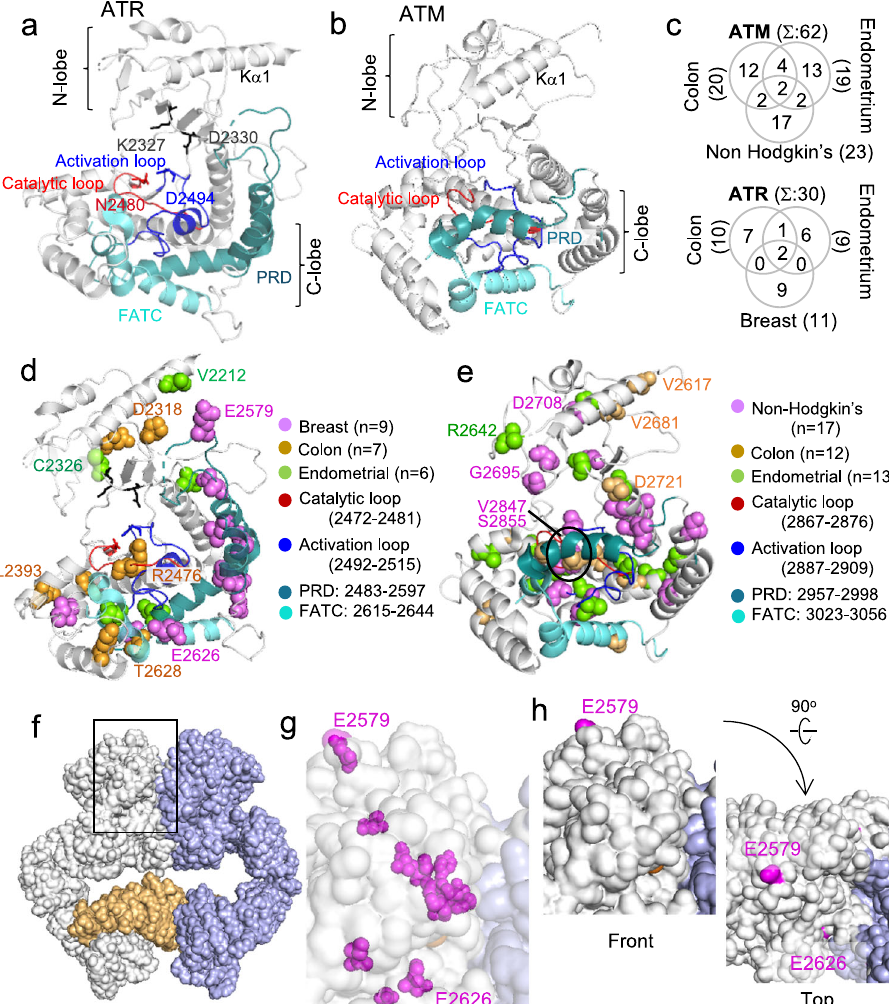
Fig. 4 Molecular modeling analysis of ATM/ATR kinase domain residues implicated in cancer. a Kinase domain of an active ATR enzyme complex (PDB 5YZO, 4.70Å) 10 . The PRD is positioned away from catalytic center to allow substrate access. The K2327 and D2330 support ATP association. The N2480 and D2494 stabilizes Mg 2 + for catalysis 10 . b Kinase domain of an inactive ATM enzyme complex (PDB 5NPO, 5.70 Å) 9 . The PRD sterically hinders substrate access to the catalytic center. c Extent of overlap among the ATM/ATR residues mutated in the indicated cancer type that are the kinase domain (Fig. 2b, Supplementary Fig. 2a, and Supplementary Data 3 and 4). d , e The kinase domains of ATR ( d ) and ATM ( e ), showing location of the conserved residues mutated in the indicated cancer type. Labeled residues are solvent accessible ( h , g ) Supplementary Fig. 4f, g). f A surface representation of the ATR enzyme complex (PDB 5YZO, 4.70 Å) 10 . The left and right ATR polypeptides are white and blue, respectively, and Ddc2 is in bright orange. Black rectangle: the kinase domain regions highlighted in g and h . g Higher resolution image of the area highlighted by a black rectangle in f . Magenta spheres: residues mutated in breast cancer shown in d . The transparency setting was set to “ on ” to visualize both the buried and exposed residues. Only the E2579 and E2626 are exposed ( h ). h Same as in g except that the transparency setting was “ off ” . Front and top views show that only the E2579 and E2626 are solvent